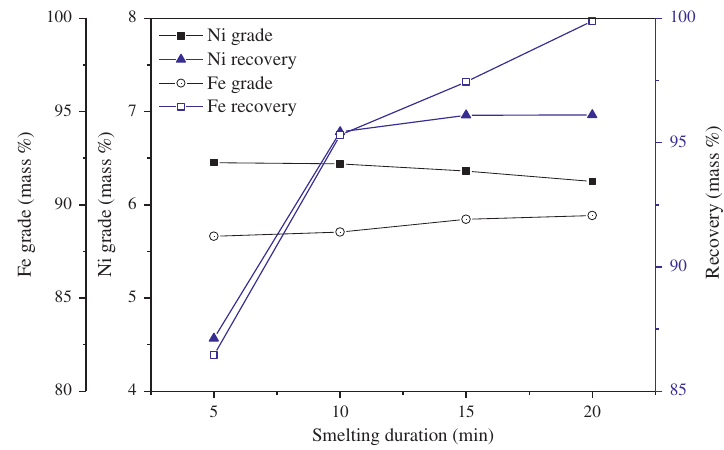
Figure 3: Effects of smelting duration on Fe and Ni grade and recovery of ferronickel (Smelting at 1,550°C with coke ratio of 7.5%, binary basicity of slag as 1.0, 18% of MgO and 3% of Al 2 O 3 in